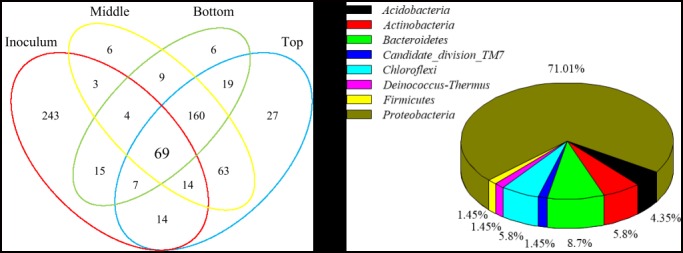
Venn diagram illustrating the overlap of the four bacterial communities from the initial inoculum and the samples of the top, middle and bottom layers.The shared OTUs (69) were analysed at the phylum level.